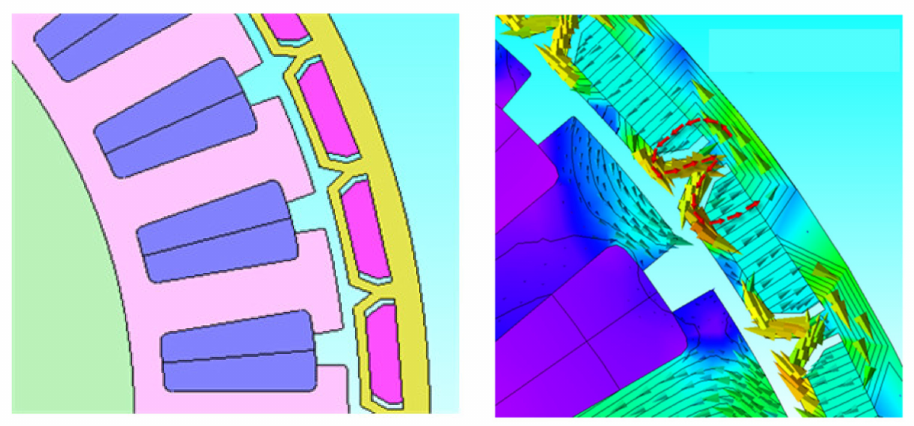
Figure 1. Analysis model and electromagnetic flux of the IPM motor. No-load simulation was performed through an electromagnetic analysis program to analyze cogging torque and back-EMV, and Figure 2 represents the analysis results. The cogging torque was measured at 0.00363 Nm peak − peak at 10 rpm, and back-EMV was measured at 5.58 V ph _ rms at 1000 rpm.